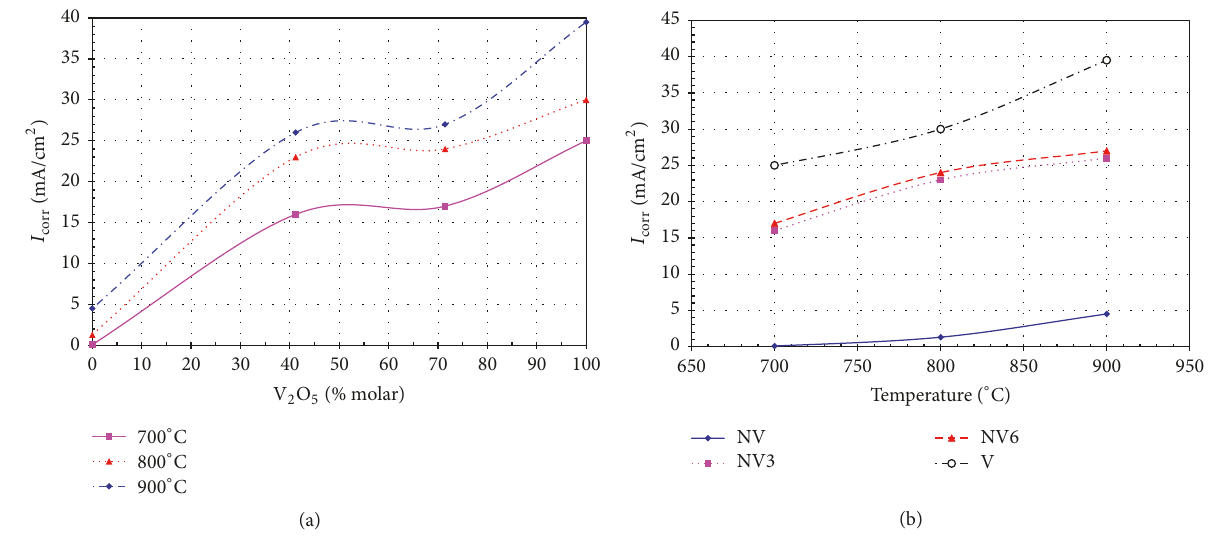
Figure 4: Effect of NV: V ratio (a) and temperature (b), on Ni corrosion rate.